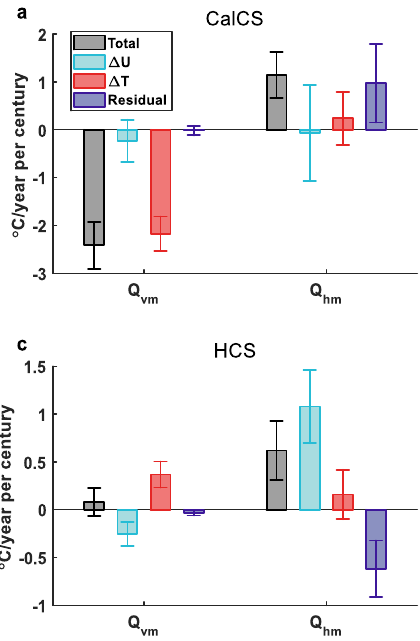
Fig. 4 | Effects of mean fl ow and mean-state temperature changes on mean- fl ow advection changes in the eastern boundary upwelling systems (EBUSs) under greenhouse warming. Decomposition of Q vm and Q hm changes into com- ponents associated with the mean fl ow changes and mean temperature gradient changesinCaliforniacurrentsystem(CalCS, a ),Canarycurrentsystem(CanCS, b ), Humboldtcurrentsystem(HCS, c )andBenguelacurrentsystem(BCS, d ).Thegray